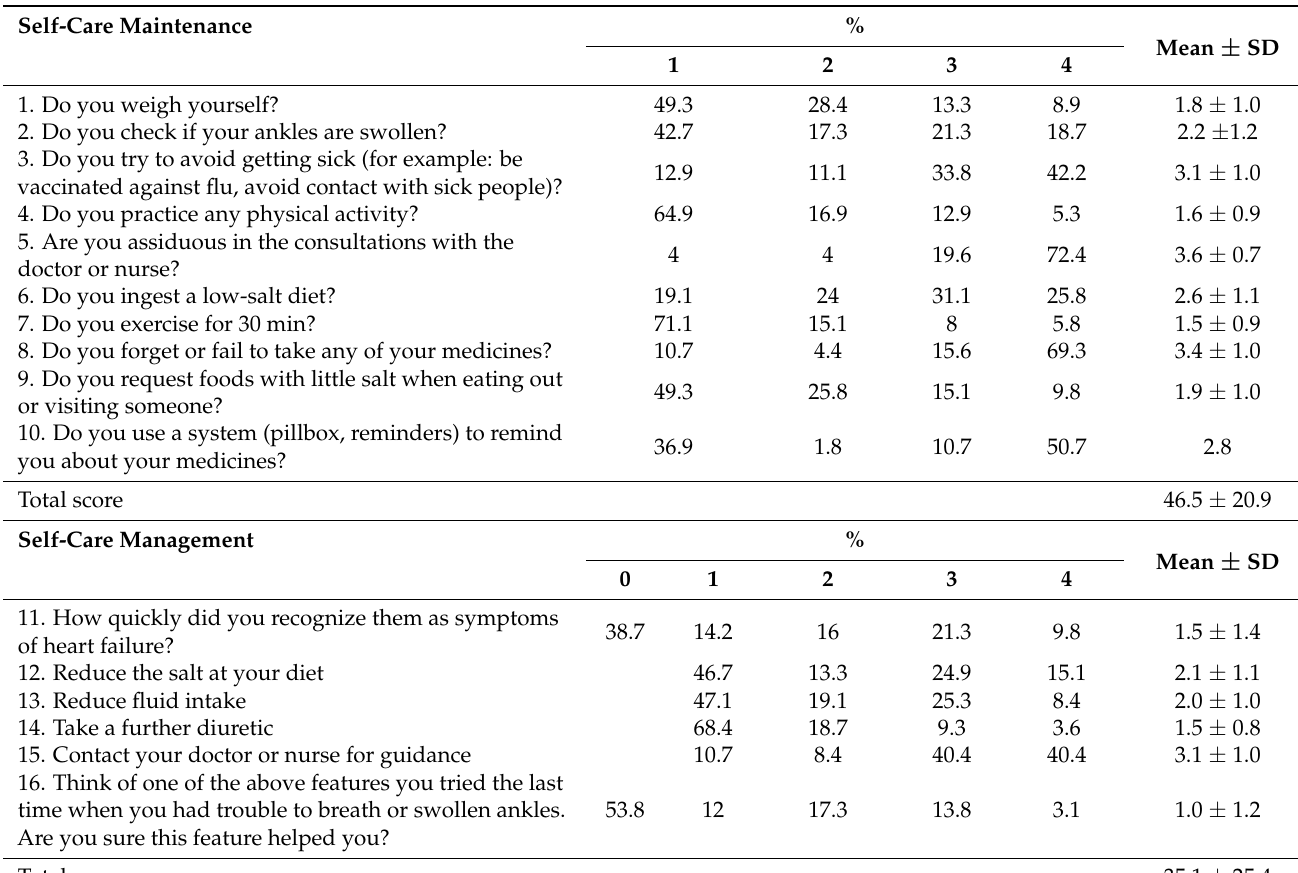
Table 2. Self-care index